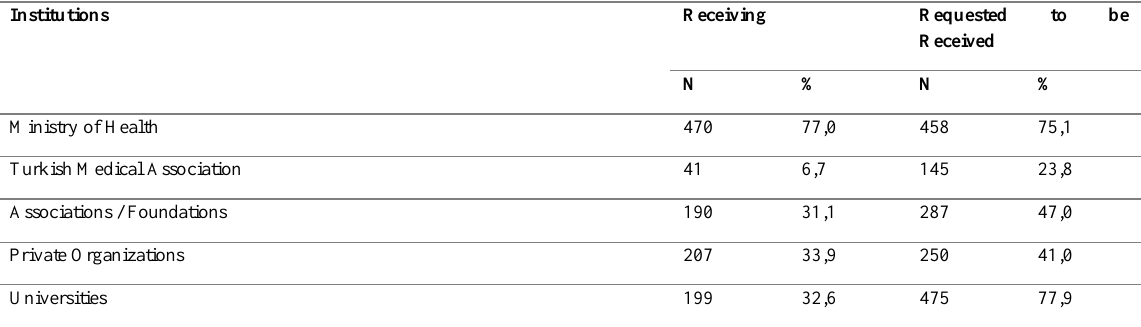
Table 14: Institutions Providing In-Service Training or Requested to Provide Institutions